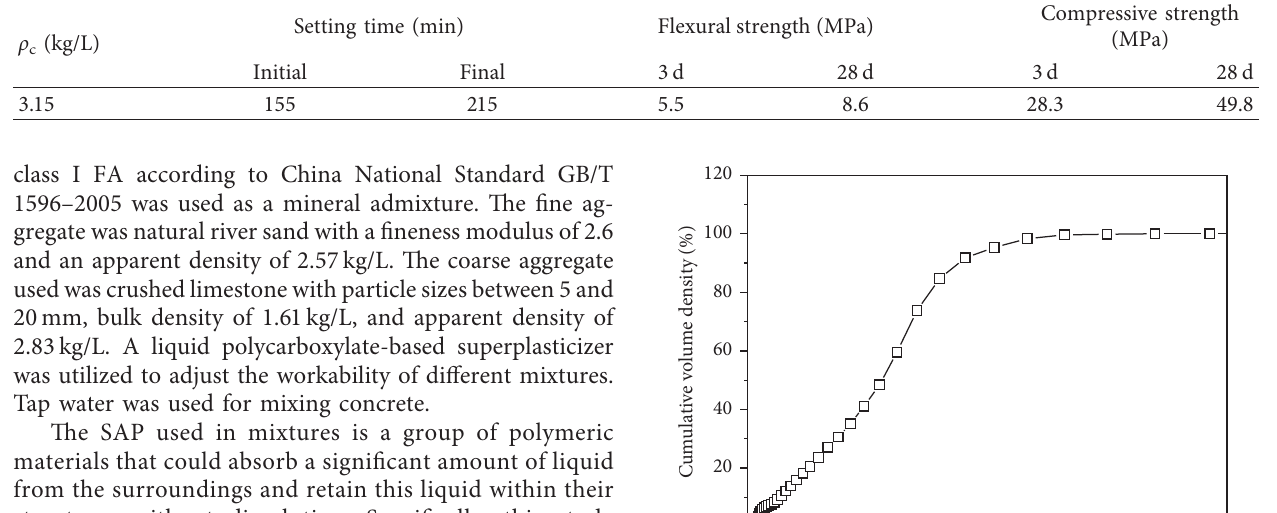
in cement pastes with mineral admixture. max